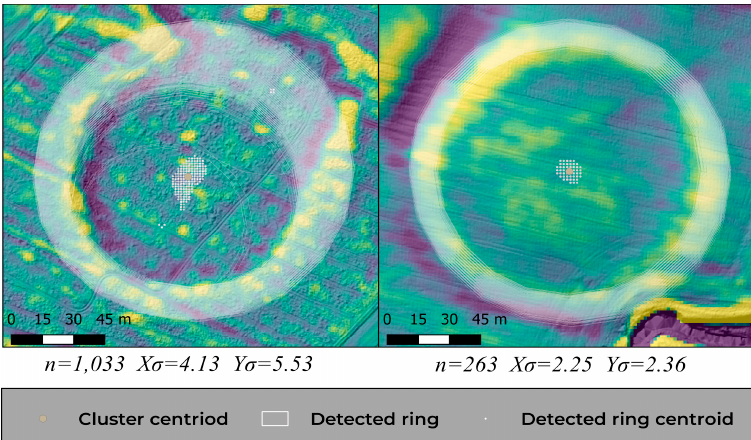
Figure 3. Point clusters from template matching, comparing an ovate glacial feature ( left ) with a circular ring fortress ( right ). A large number of superimposed and adjacent rings were detected for each feature. The DBSCAN algorithm was used to identify clusters of points within 2.26 meters of each other (the diagonal of one pixel). The coordinate used for each cluster (of n points) was used as the center of the detected points. A ratio between the standard deviation ( σ ) of the X and Y coordinates of each point cluster was used to estimate concentricity.